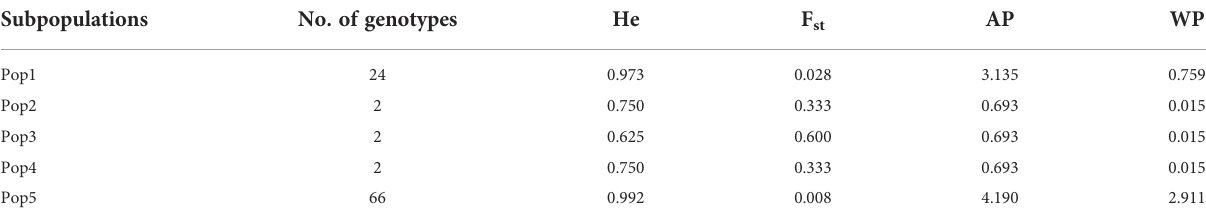
TABLE 3 Structure analysis of 96 barley genotypes.